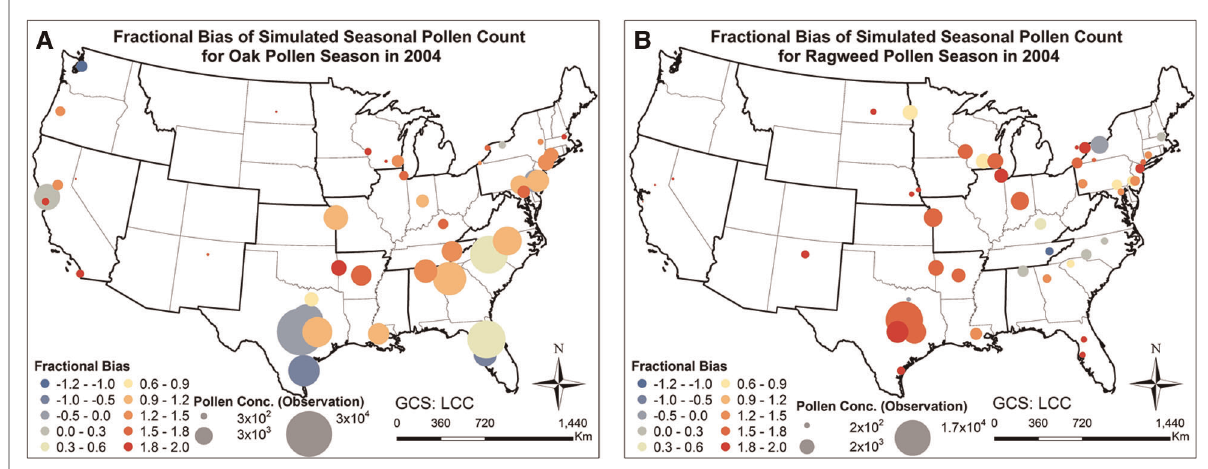
FIGURE 6 Fractional biases of pollen concentrations calculated with the CMAQ-Pollen model for 2004 in the CONUS. ( A ) Fractional bias of seasonal oak pollen counts; ( B ) Fractional bias of seasonal ragweed pollen